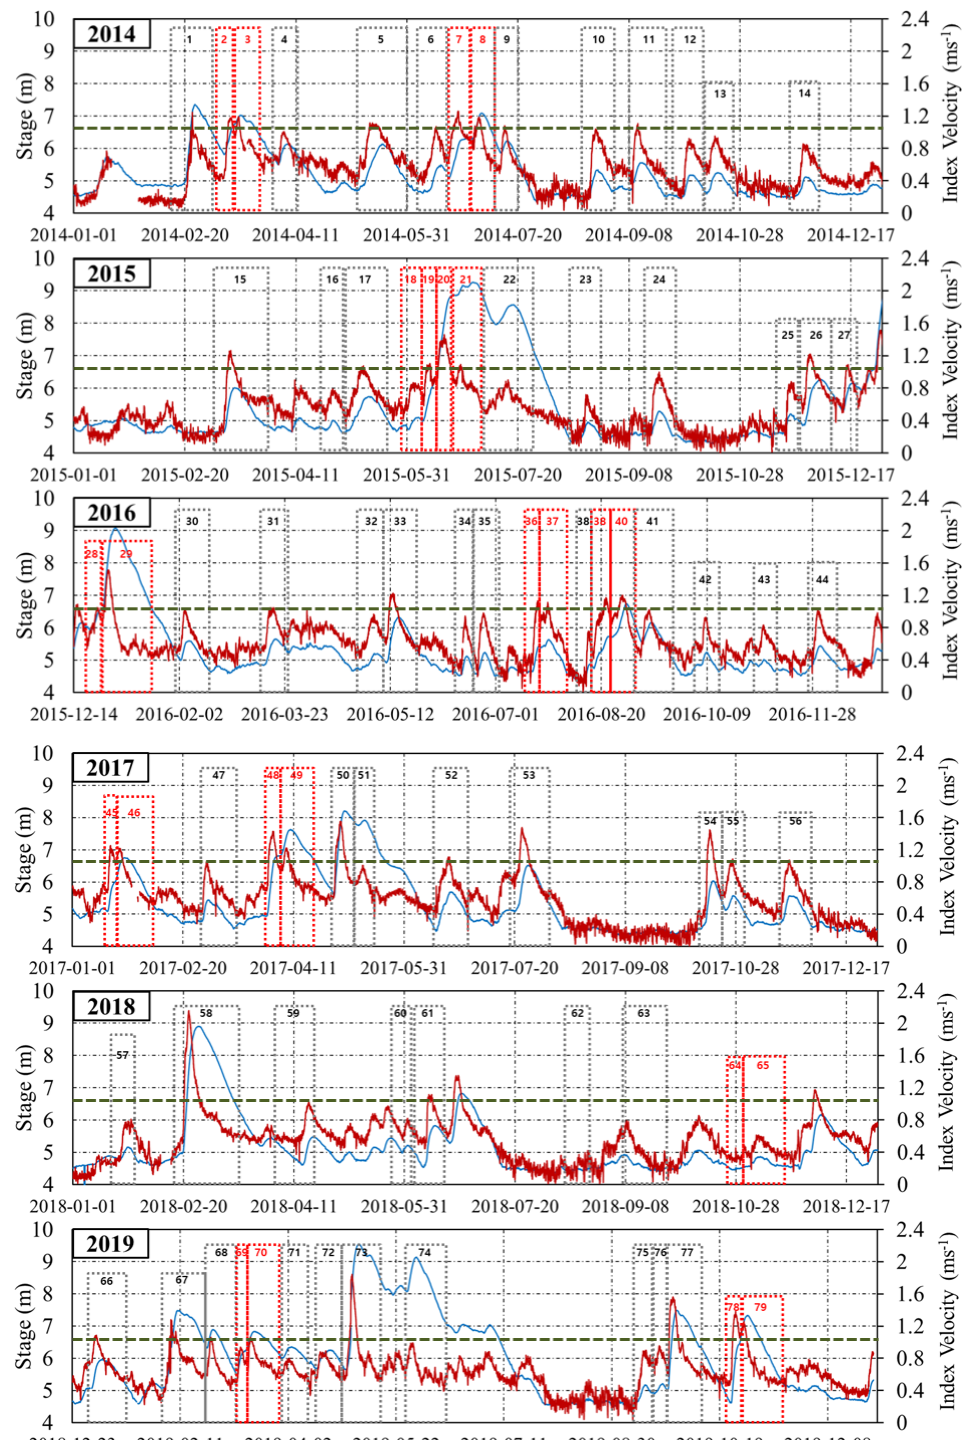
Figure 3. Time series of the stage and index velocity measured at the USGS gaging station #0555830 for supporting IVRC implementation. The numbering in the figure tracks the storm events in chronological order. Table 2. Characteristics of the major storm events during the Water Year 2017.